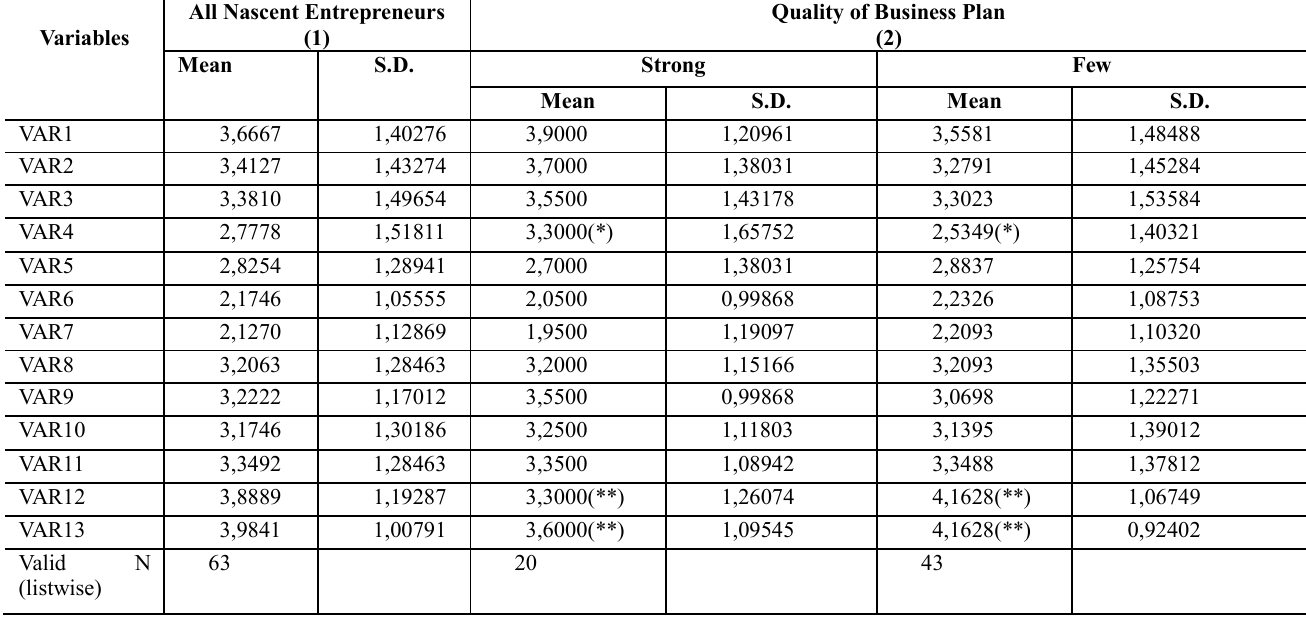
Table 1: Factors behind the failure to obtain VC financing in the pre-start-up phase: Mean, standard deviation and a Mann-Whitney test of differences between means by categories